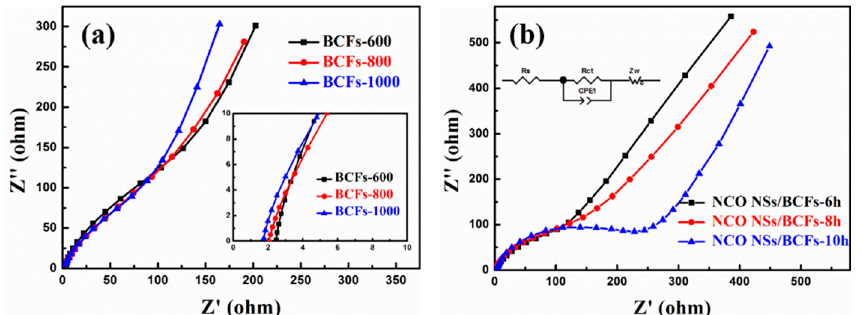
Figure 6. Nyquist plots of ( a ) BCFs; ( b ) NCO NSs/BCFs composite.